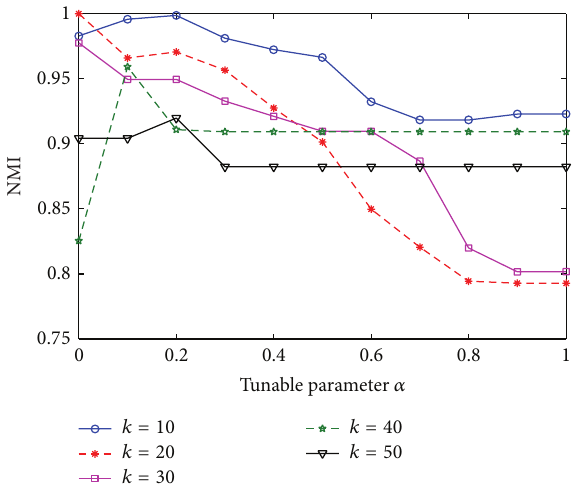
Figure 9: The value of NMI under different tunable parameter 𝛼